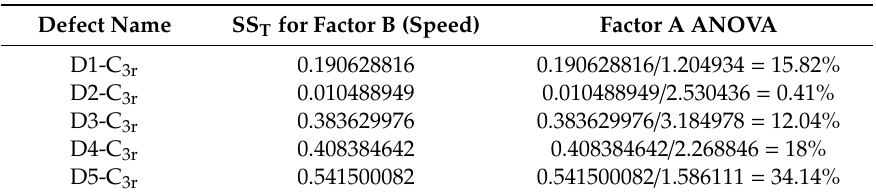
Table 8. Factor B ANOVA for C100 \ Q1.